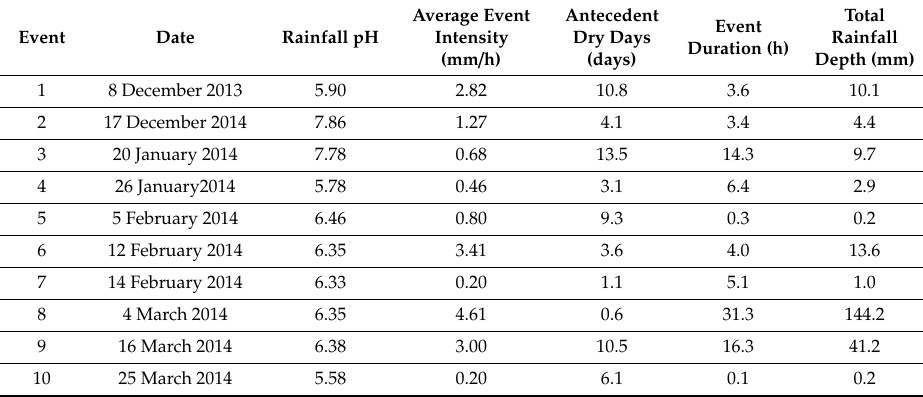
Table B1. Okeover sampled event characteristics, used for calibration. Table A1. Okeover sampled event characteristics, used for